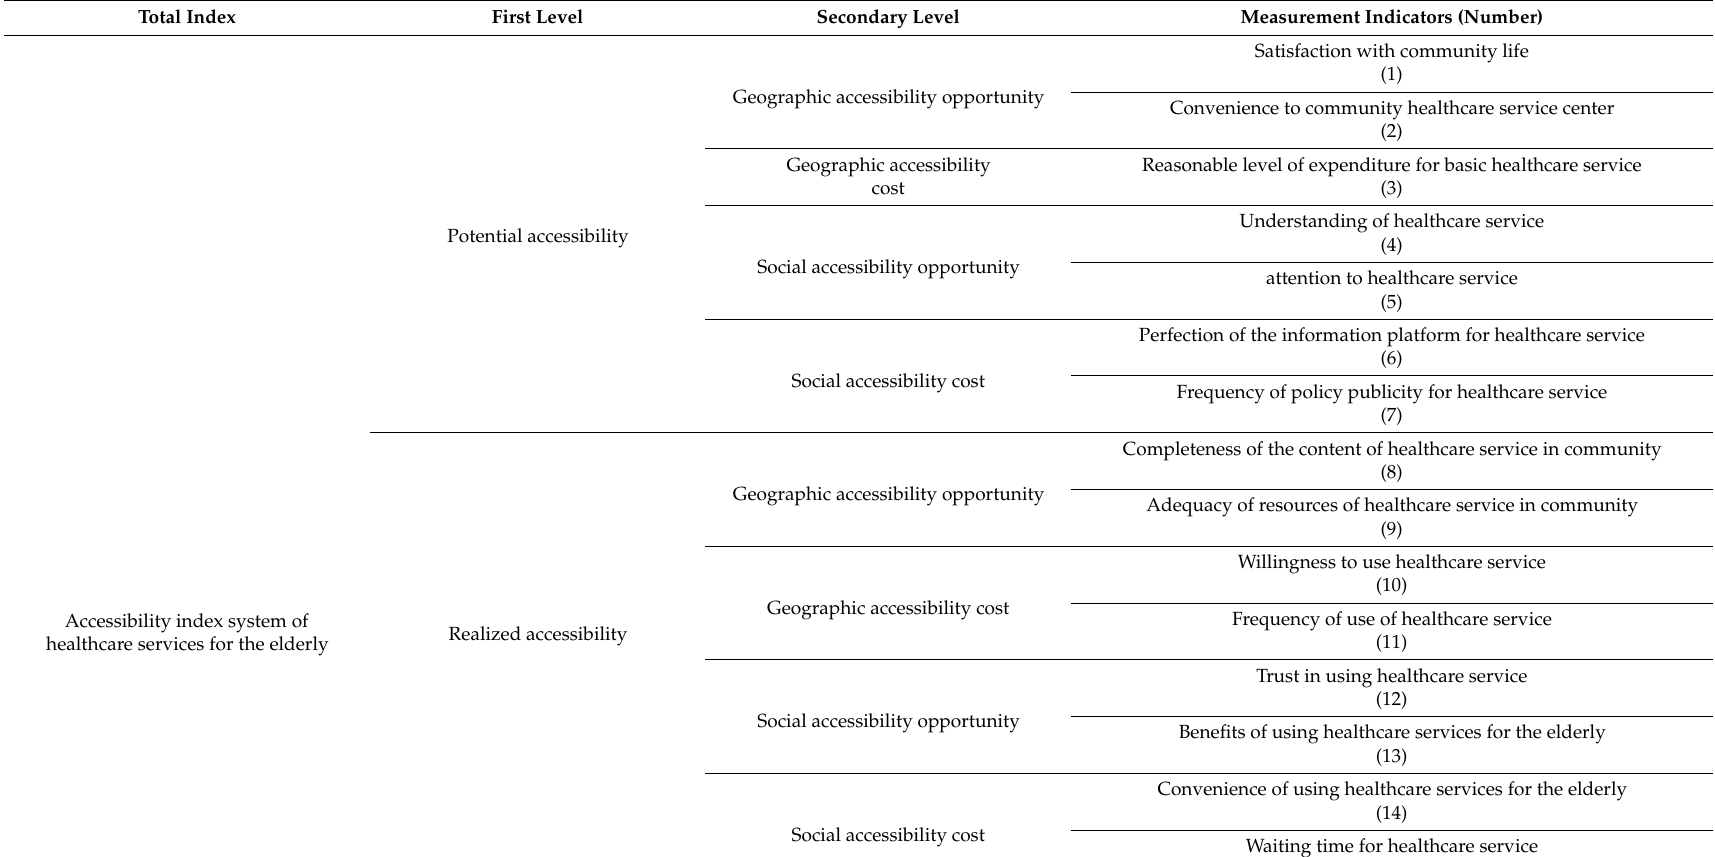
Table 2. Accessibility index system of healthcare services for the